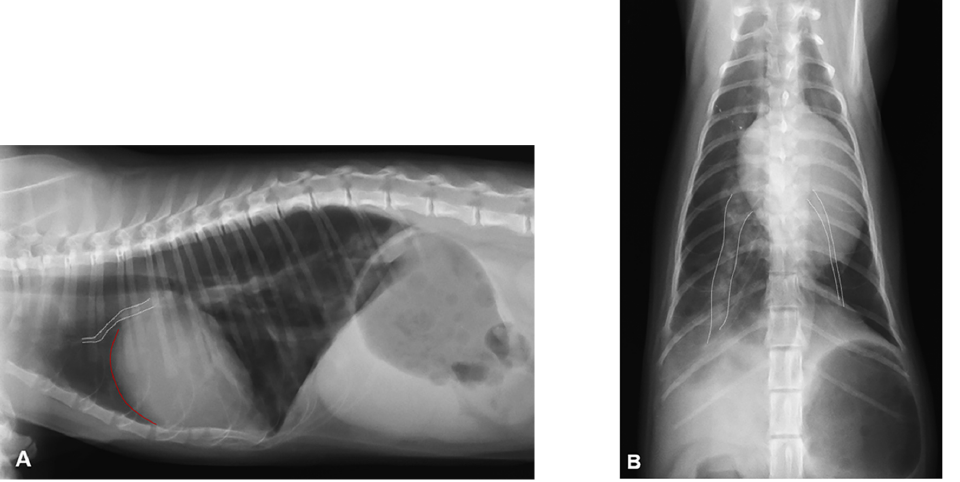
Figure 1. Thoracic radiography at presentation shoving an interstitial pulmonary pattern in the right caudal lung lobe: ( A ) Right lateral view showing cardiomegaly with increased convexity of the cranial cardiac border (red line) and prominent and tortuous right cranial pulmonary artery (white dotted lines). ( B ) Dorso-ventral view showing severe asymmetry of the caudal pulmonary arteries with severely enlarged and hypovascular right and left caudal pulmonary artery, respectively (white dotted